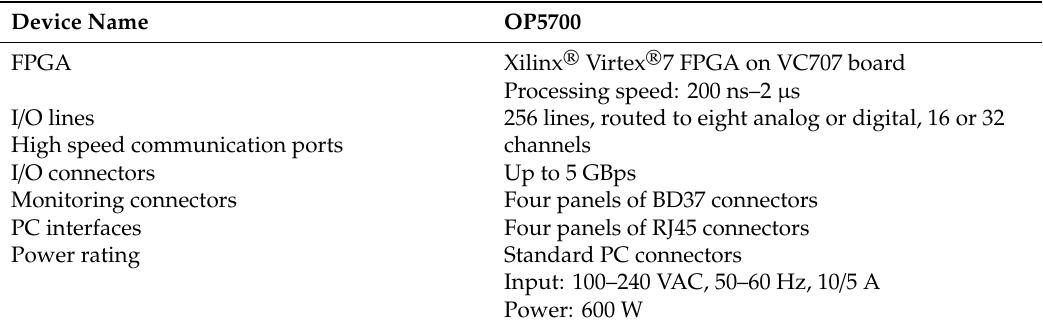
Table 1. Hardware-in-Loop (HIL) Specifications.